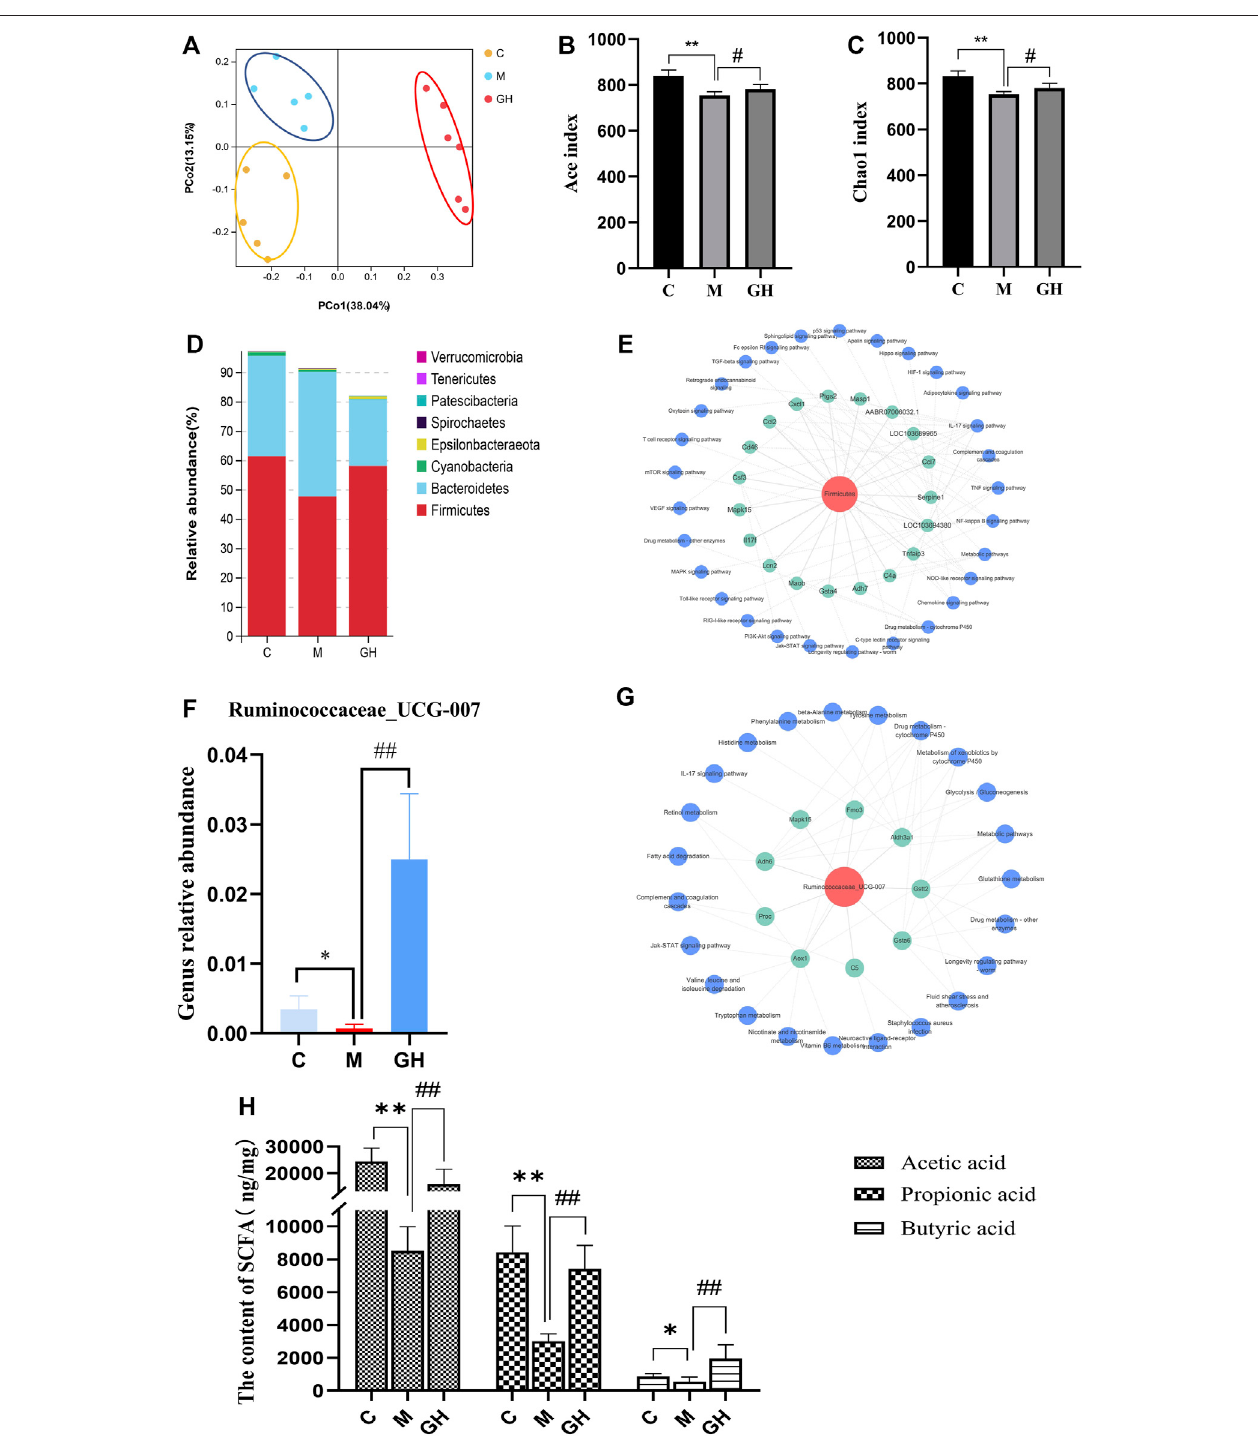
FIGURE 7 | Effect of GQD on coliform bacteria in ALI rats induced by intratracheal injection of LPS. (A) PCoA analysis of intestinal fl ora in different groups of rats. Each point in the fi gure represents the sample, the closer the point distance on the plane, the more similar the structure of the color of the sample. (B,C) Alpha diversity analysis of gut bacterial richness from different mouse groups. (D) Distribution map of phylum level of intestinal fl ora in each group of rats. The vertical coordinate indicatestherelativeabundanceofthespecies,theAbscissaindicatesthegrouping,Cistheblankgroup,Misthemodelgroup,andGHistheGQDadministration group. (E) Firmicutes-gene-pathwaynetworkdiagram.TheredinthepictureisFirmicutes,thegreenisthegene,andtheblueisthepathway. (F) Therelativeabundance of Ruminococcaceae_UCG_007 in each group. (G) Ruminococcaceae_UCG_007-Gene pathway network diagram. In the fi gure, the red is Ruminococcaceae_UCG_007, thegreenisthegene, andtheblueisthepathway. (H) Thecontentofshort-chainfatty acids(aceticacid,propionicacidandbutyricacid) in fecal samples of rats in each group. Compared with the control group, * p < 0.05, ** p < 0.01; compared with the model group, # p < 0.05, ## p < 0.01, n = 6.